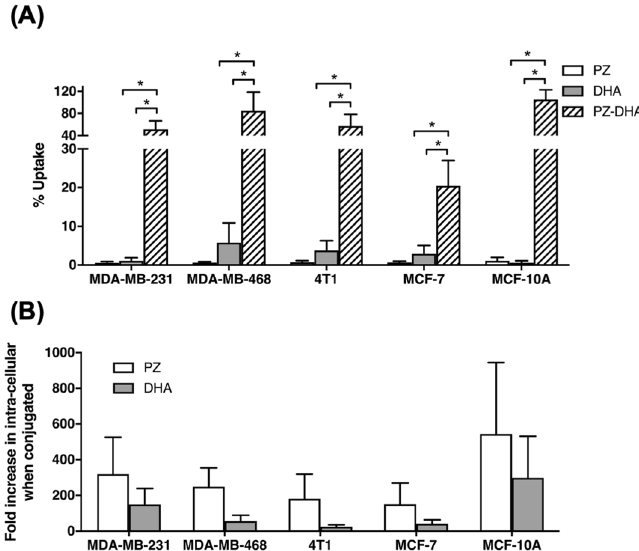
Figure 1. Conjugation of PZ with DHA increases the cellular uptake and stability of PZ and DHA. The cells were treated with 20 μM of PZ, DHA or PZ-DHA and cultured for 72 h at 37 °C. Cells were harvested and washed thoroughly using cold PBS. Cells were lysed in cold acetone containing 0.05 mg/mL quercetin, and cell lysates were collected by centrifugation and analyzed by using UPLC-ESI-MS/MS. (A) mean % cellular uptake of PZ, DHA and PZ-DHA. ( B ) fold increase in intracellular PZ and DHA when conjugated. ANOVA multiple means statistical comparison method was performed and differences among means were compared